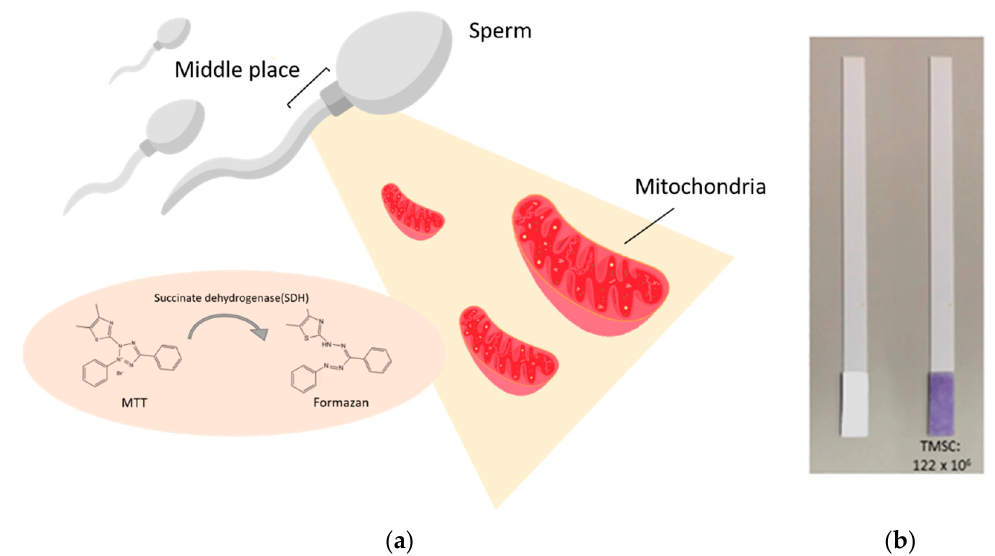
Figure 1. The mechanism and colorimetric results from a 3-(4,5-Dimethylthiazol-2-yl)-2,5- Figure 1. Themechanismandcolorimetricresultsfroma3-(4,5-Dimethylthiazol-2-yl)-2,5-diphenyltetrazolium diphenyltetrazolium bromide (MTT) test strip. ( a ) The mechanism of sperm and MTT interaction. bromide (MTT) test strip. ( a ) The mechanism of sperm and MTT interaction. There is an abundance of There is an abundance of mitochondria in the middle portion of the sperm cell, where succinate mitochondria in the middle portion of the sperm cell, where succinate dehydrogenase (SDH) located dehydrogenase (SDH) located on the mitochondria transforms MTT into formazan. ( b ) The color of on the mitochondria transforms MTT into formazan. ( b ) The color of the MTT test strip before and after the MTT test strip before and after testing the semen sample. The colorimetric result is homogenously testing the semen sample. The colorimetric result is homogenously distributed over the testing zone of the distributed over the testing zone of the MTT test strip and the result can be easily interpreted by visual MTT test strip and the result can be easily interpreted by visual observation or with a smartphone-based observation or with a smartphone-based recording and analytical system. MTT: 3-(4,5-Dimethyl-2- recording and analytical system. MTT: 3-(4,5-Dimethyl-2-thiazolyl)-2,5-diphenyl-2H-tetrazolium bromide. thiazolyl)-2,5-diphenyl-2H-tetrazolium bromide. (Adapted image from [2]). (Adapted image from